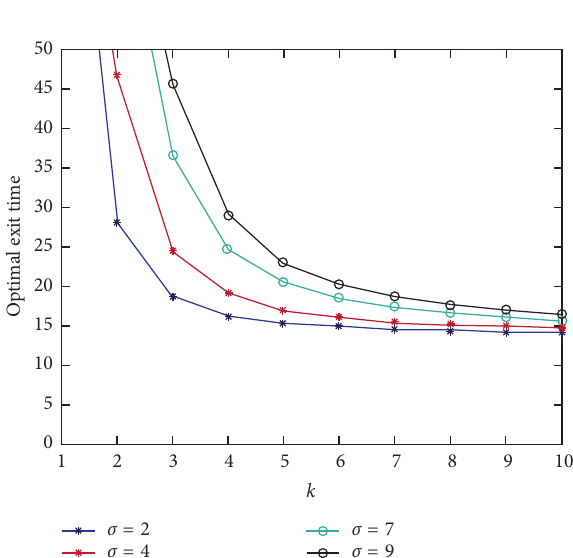
Figure 9: The optimal exit timing.